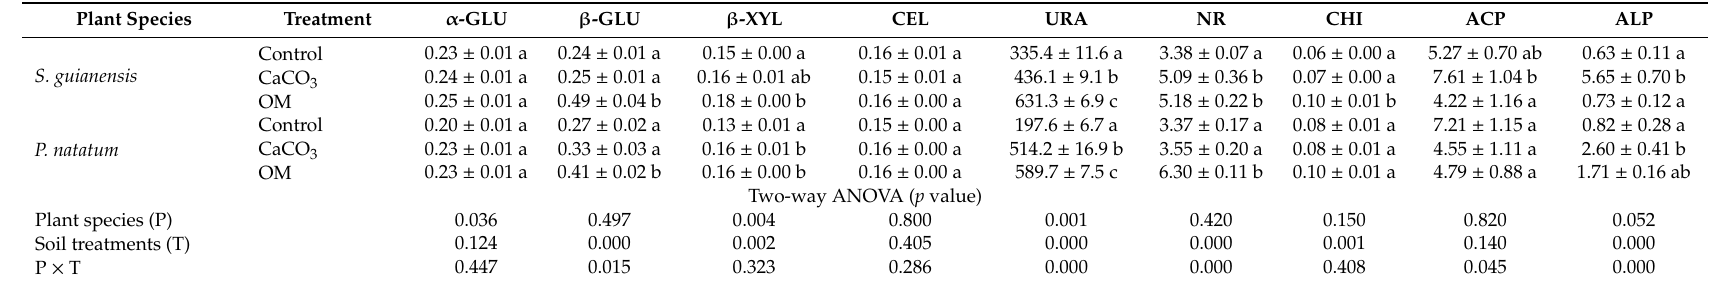
Table 2. Influences of liming (CaCO 3 ) and plant residue incorporation (OM) on soil enzyme activities. α -GLU, α -glucosidase; β -GLU, β -glucosidase; β -XYL, β -xylosidase; CEL, cellobiosidase; URA, urease; NR, nitrate reductase; CHI, chitinase; ACP, acid phosphatase; ALP, alkaline phosphatase. Data followed by the same letter are not significantly di ff erent for each plant species (Tukey’s post hoc test, p = 0.05, n = 5). Enzymatic activity unit of URA, NR, ACP, ALP is U · g − 1 , and that of others is µ mol · L − 1 MUF · g − 1 · h − 1